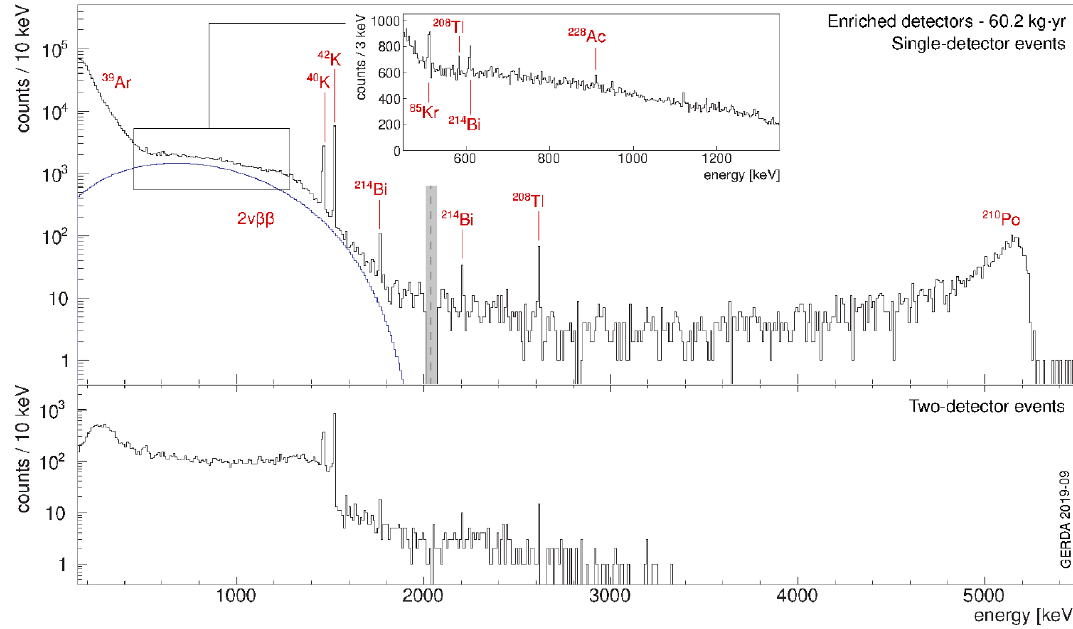
Figure 2. Summed energy spectra of single-detector events ( M1-enrBEGe and M1-enrCoax , top panel) and two-detector events ( M2-enrGe , bottom panel) collected in Gerda Phase II. The promi- nent features due to detector intrinsic 2 (cid:23)(cid:12)(cid:12) events, 42 K, 39 Ar and 85 Kr in the LAr, 40 K, the 232 Th and 238 U decay chains are highlighted. The window blinded for the 0 (cid:23)(cid:12)(cid:12) analysis ( Q (cid:12)(cid:12) (cid:6) 25 keV) is marked in